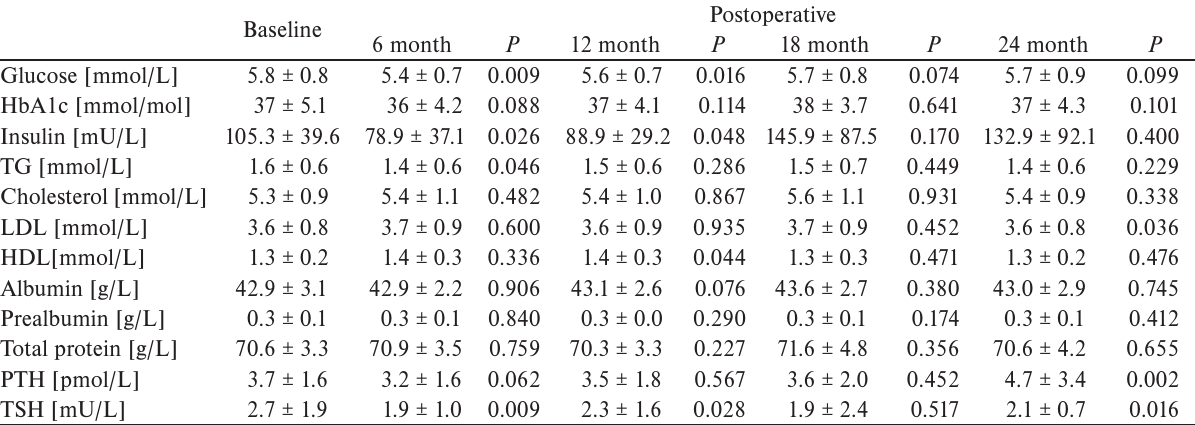
Table 3. Nutritional parameters before and 6, 12, 18, and 24 months after ESG (n=20). Baseline